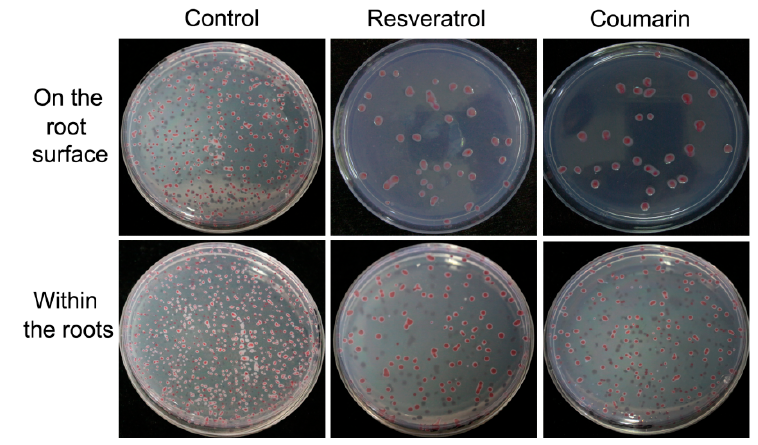
Figure 8. Representative SMSA-agar plate images of R. solanacearum colony in root exterior and interior after treatment with 128 μ g/mL of coumarin and resveratrol on Day 5 after inoculation. After treatment with both phytochemical for five days, 10 − 3 to 10 − 5 bacterial suspensions were used for the test. Table 3. Effects of coumarin and resveratrol on rhizosphere colonization of R. solanacearum in tobacco. On the Root Surface Treatments